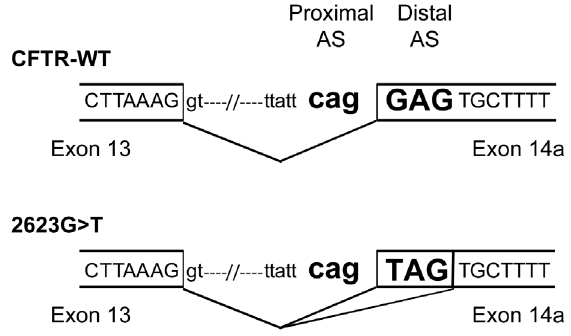
Figure 6. Schematic representation of the intron 13/exon 14a junction. Proximal and distal acceptor sites (AS) are indicated both on the WT and 2623G . T sequences. The tandem splice acceptor site is highlighted in bold. A broken line represents splicing